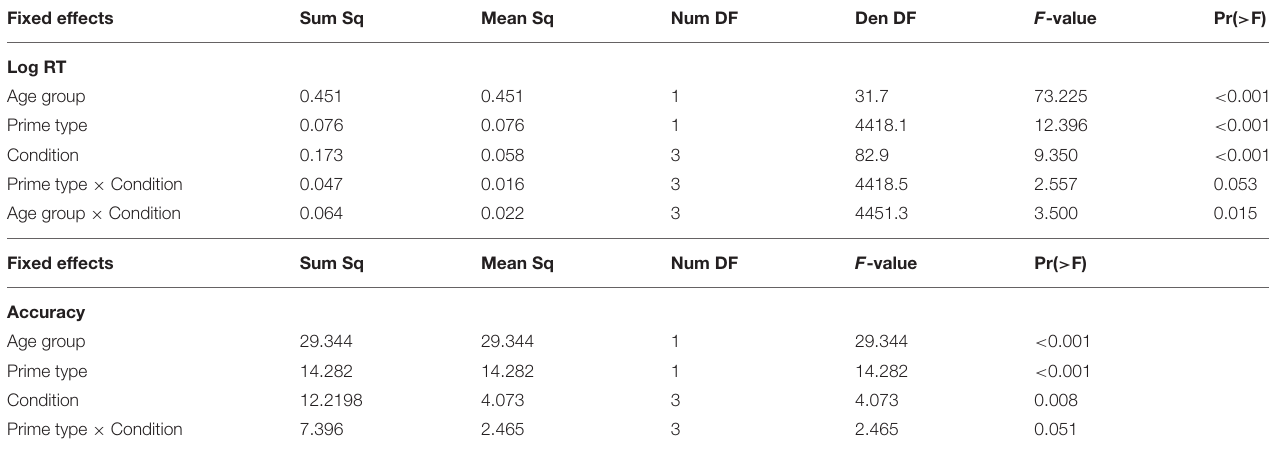
TABLE 8 | Results from the ANOVA approach to linear mixed-effects model analysis of log RT and accuracy rates in Experiment 4 with 72ms prime